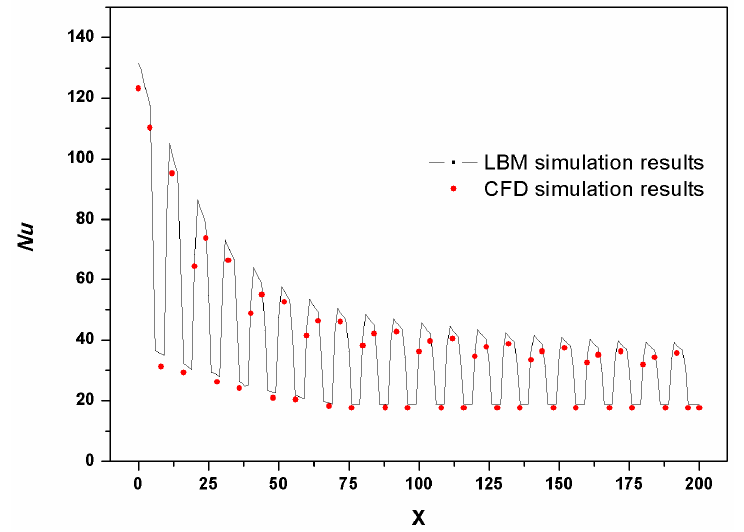
Figure 8. The flow direction Nu distributions obtained by the LB method and CFD